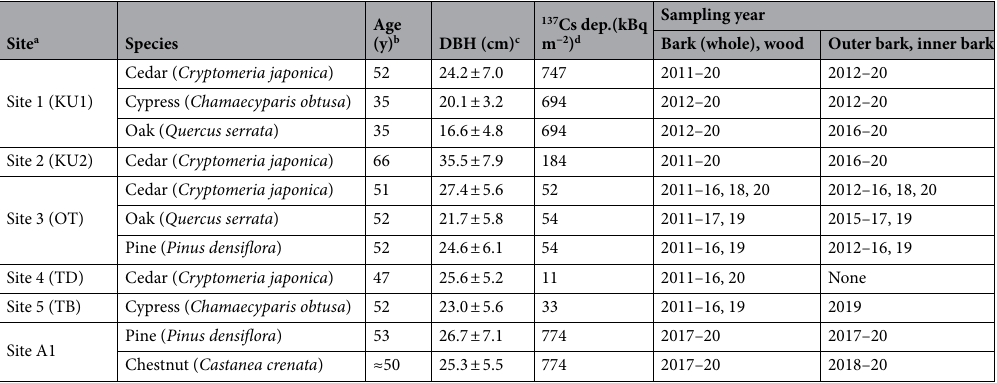
Table 1. Description of the sampled trees and monitoring sites. a Site names in parentheses correspond to those in the study of Imamura et al. 31 . b Tree age as of 2020. c Mean ± standard deviation of sampled trees. d Initial deposition density of 137 Cs following the Fukushima nuclear accident as of July 2, 2011, estimated by Kato et al. 21 . DBH , diameter at breast